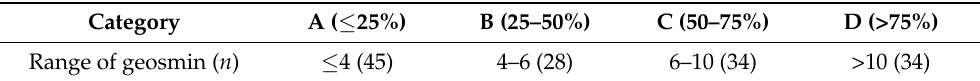
Table 3. Categories of geosmin concentration were defined based on the boxplot method. The numbers in parenthesis ( n ) indicate the number of sampling